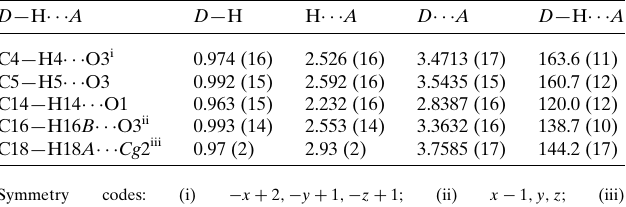
Table 1 Hydrogen-bond geometry (A˚ , (cid:3) ).